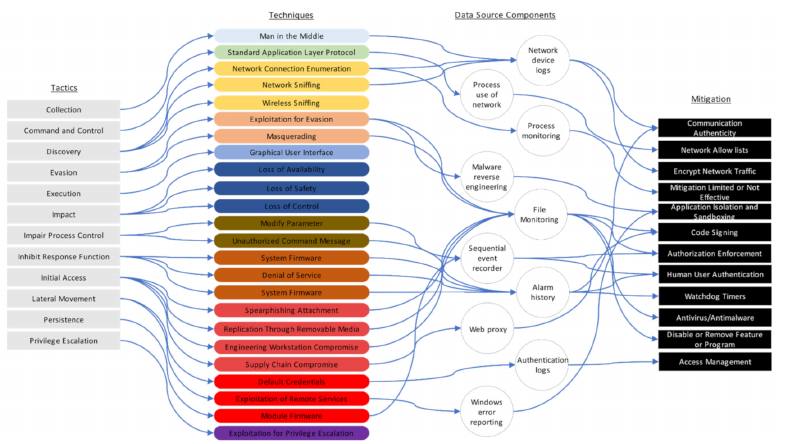
Figure 7. Analysis of ship TTPs by MITRE ATT&CK Enterprise.